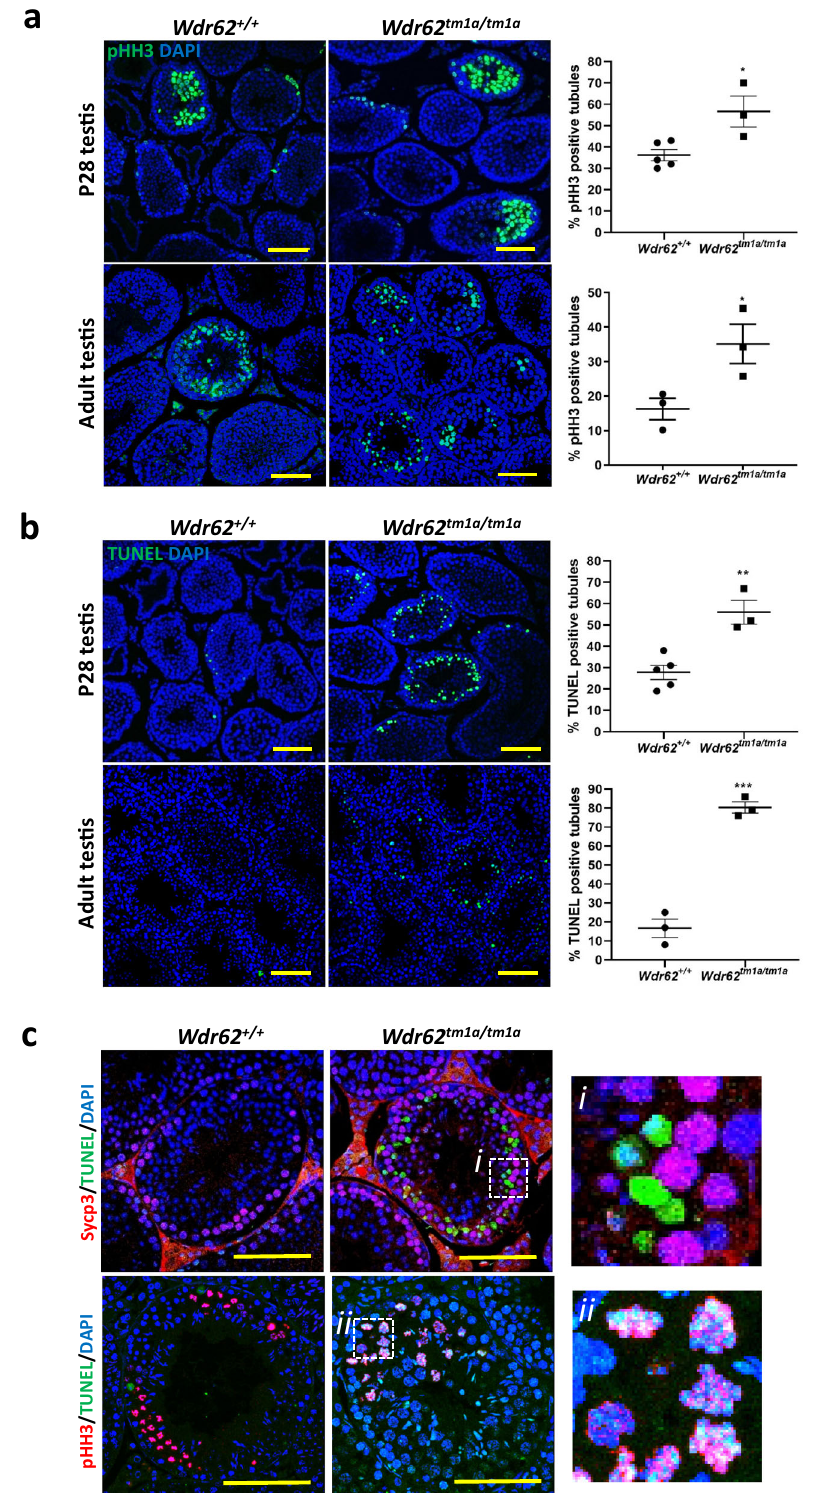
Fig. 3 Increased metaphase and apoptotic spermatocytes in Wdr62 tm1a/tm1a testis. a . pHH3 (green) immuno fl uorescence in P28 and adult testis. Negative IgG control is shown in Supplementary Fig. 7c. The percentage of pHH3-positive tubules was quanti fi ed. n = 5 Wdr62 + / + and 3 Wdr62 tm1a/tm1a P28 testes; 3 Wdr62 + / + and 3 Wdr62 tm1a/tm1a adult testes. Two-tailed unpaired Student ’ s t -test, * p = 0.0184 (P28 testis), * p = 0.0442 (adult testis). b TUNEL (green) staining in P28 and adult testis. The percentage of TUNEL-positive tubules was quanti fi ed. n = 5 Wdr62 + / + and 3 Wdr62 tm1a/tm1a P28 testes; 3 Wdr62 + / + and 3 Wdr62 tm1a/tm1a adult testes. Two-tailed unpaired Student ’ s t -test, ** p = 0.0035 (P28 testis), *** p = 0.0004 (adult testis). c SYCP3 or pHH3 (red) and TUNEL (green) co-staining in the adult testis. Inset = 50 μ m × 50 μ m magni fi ed area of dashed box. All sections were counterstained with DAPI (blue). All scale bars represent 100 μ